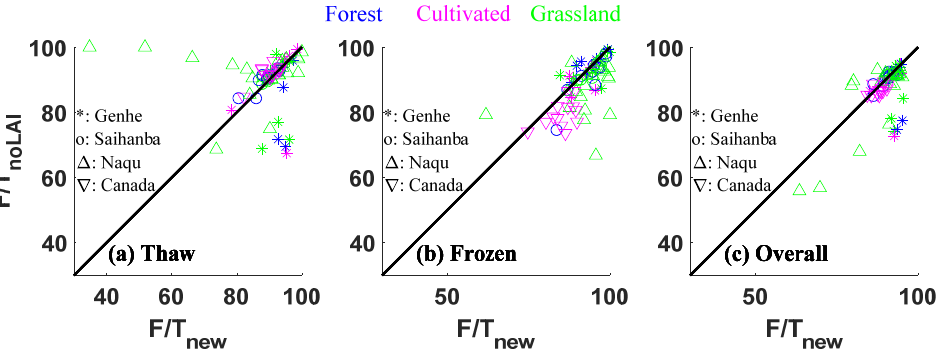
Table 6. Total classification accuracy (%) statistics for F/T new and F/T new_noLAI .